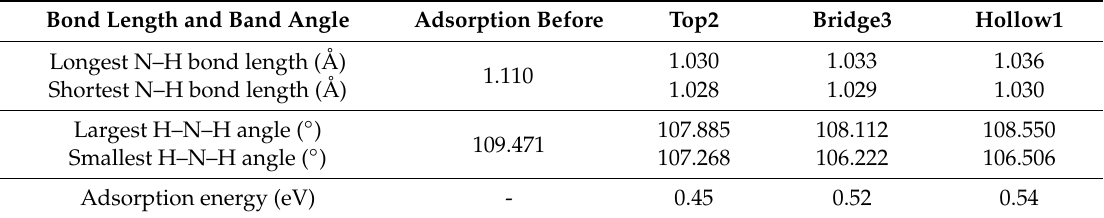
Table 3. The structural parameters for NH 3 adsorbed on “Top2”, “Bridge3”, and “Hollow1” of the kaolinite (001) surface.